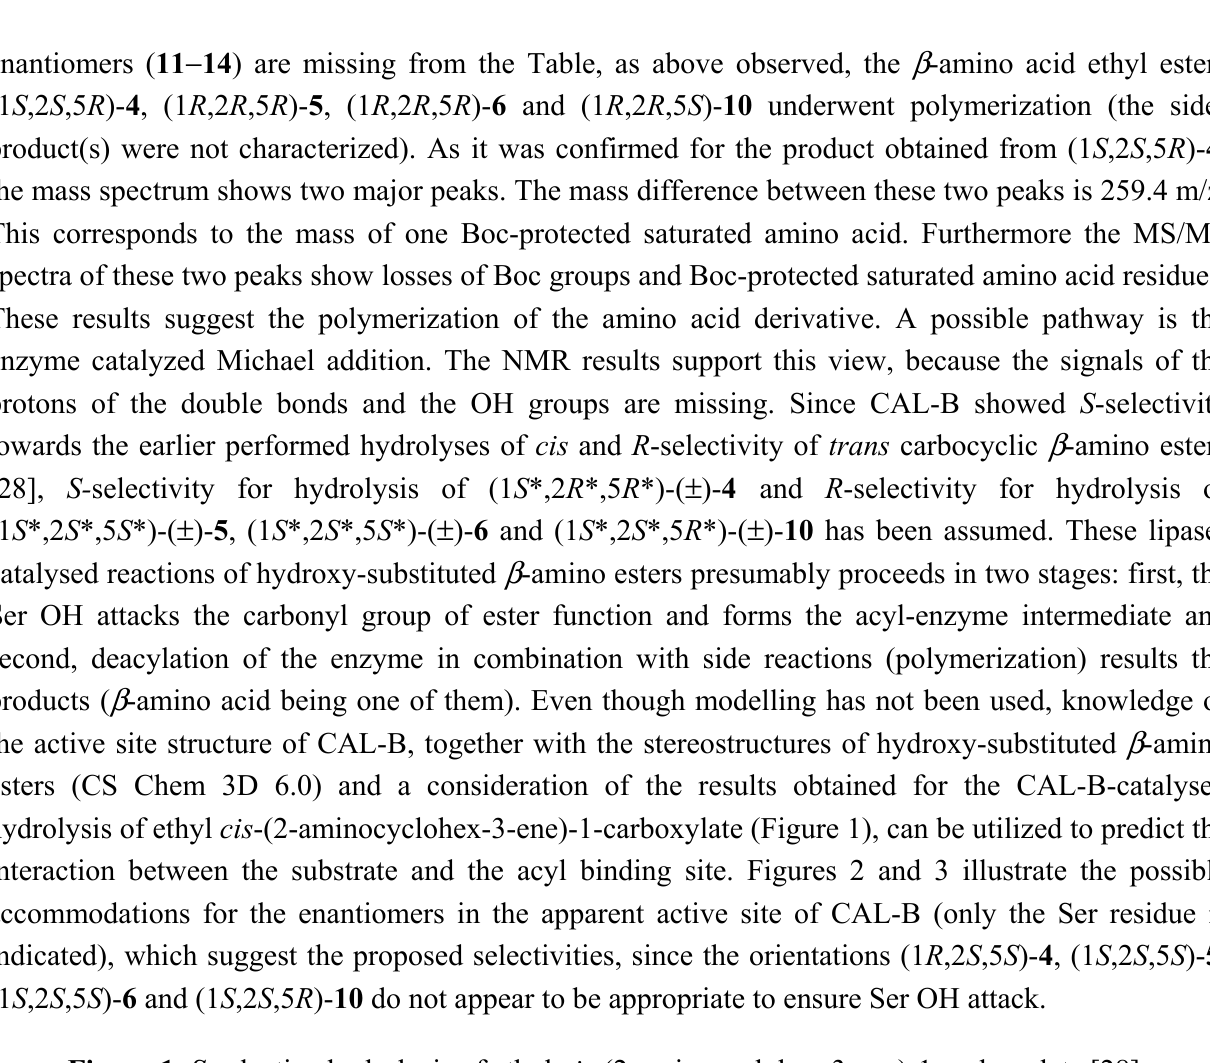
Figure 1. S -selective hydrolysis of ethyl cis -(2-aminocyclohex-3-ene)-1-carboxylate